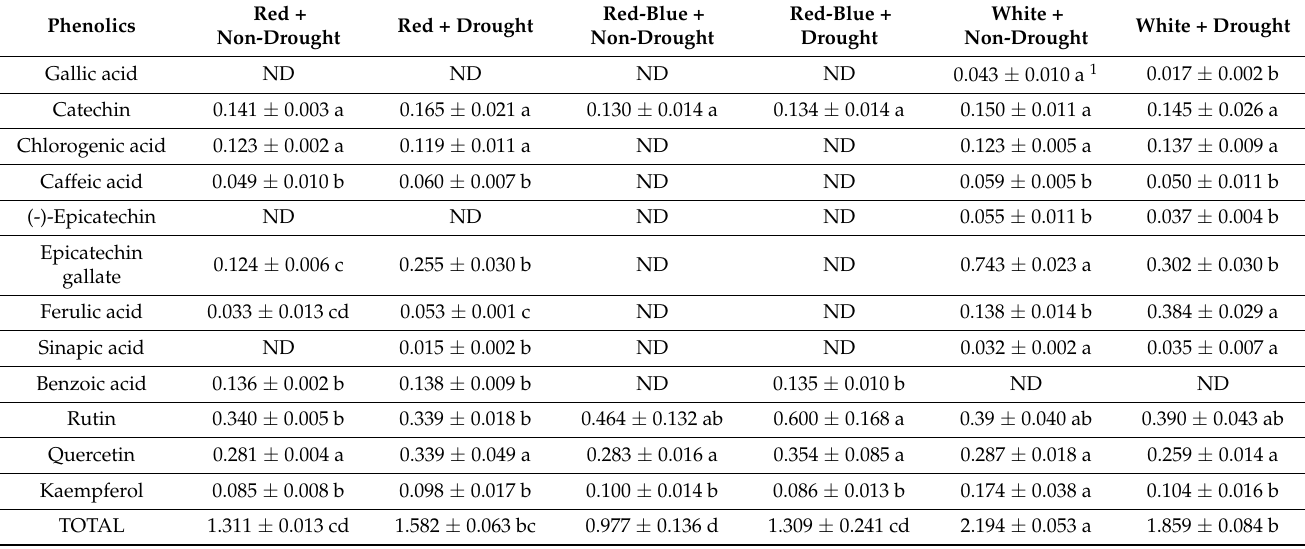
Duncan’s multiple range test (n ≥ 3, mean ± SD).